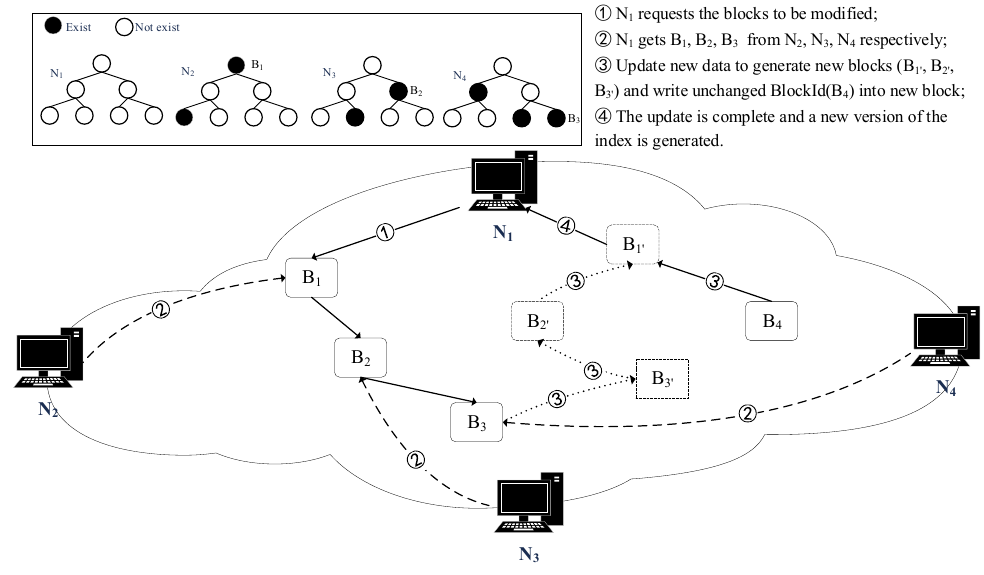
Figure 3. The details of remote